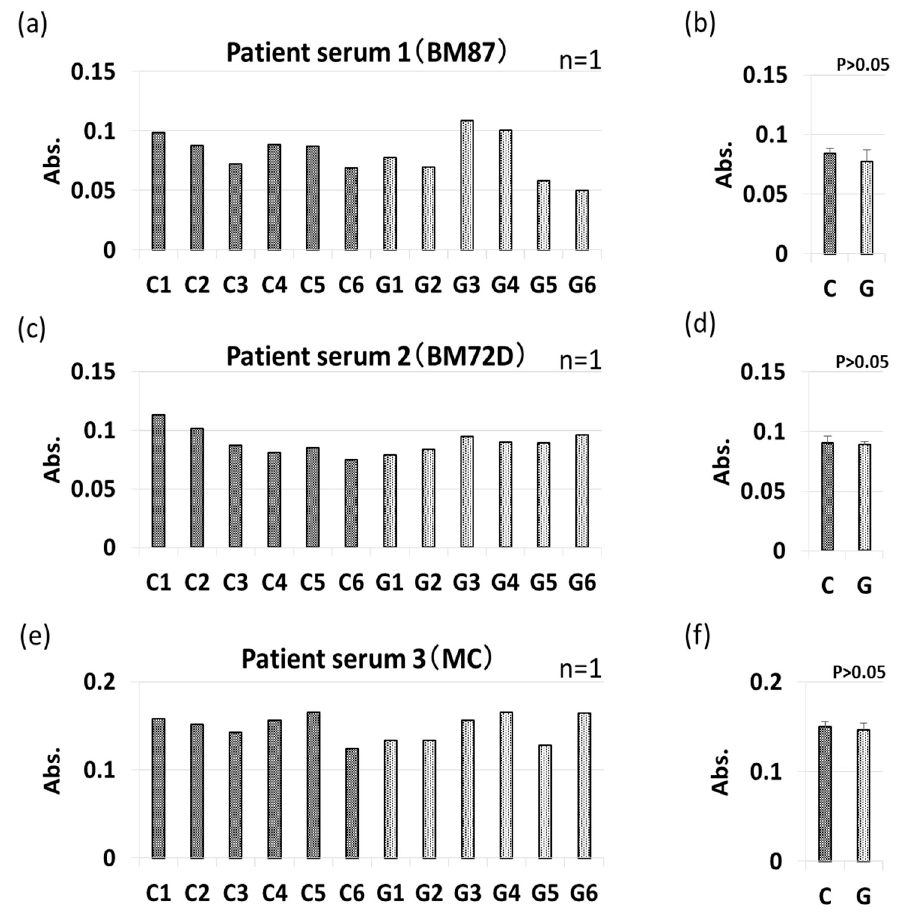
Figure 10 . IgE-ELISA of GM-and non-GM soybeans using patient sera. IgE-ELISA performed using sera from three soybean-allergenic patients is shown as follows: patient serum 1 (a,b) , patient serum 2 (c,d) , patient serum 3 (e,f) . The collated data (b,d,f) are presented as the mean ± SD of all individual data points from the control (C1–C6, non-GM soybeans) or experimental (G1–G6, GM soybeans) groups for each serum sample.